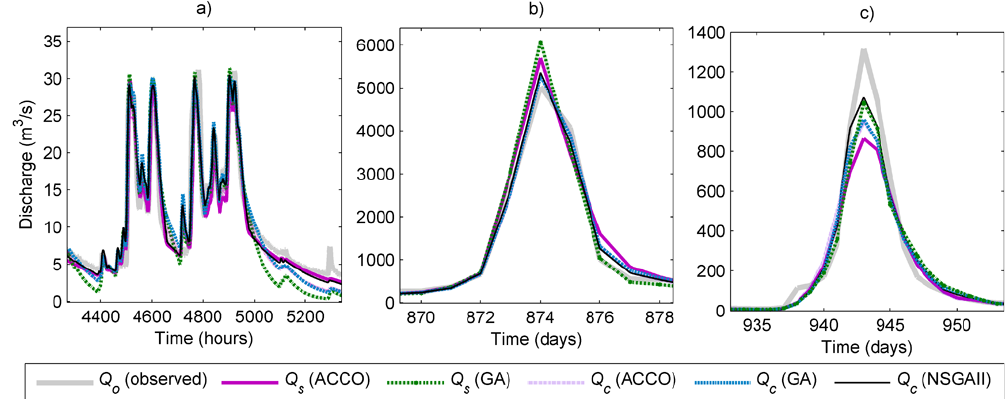
Fig. 4. A fragment of a hydrograph generated from various models: Q o – observed discharge, Q s – model identified by single-objective optimization (ACCO and GA), Q c – committee model (ACCO, GA and NSGA-II), (a) Alzette (31/01/2002 08:00:00–18/03/2002 03:00:00), (b) Bagmati (20/5/1990–28/5/1990), and (c) Leaf (13/02/1960–08/03/1960).